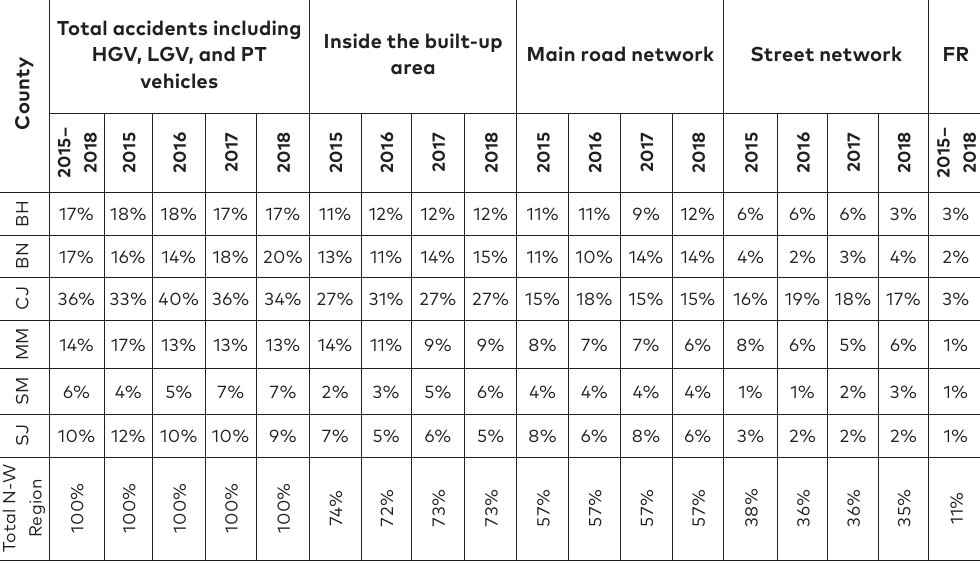
Table 5. Accident and fatality rates of accidents involving HGV, LGV and PT vehicles by county (source: author*,